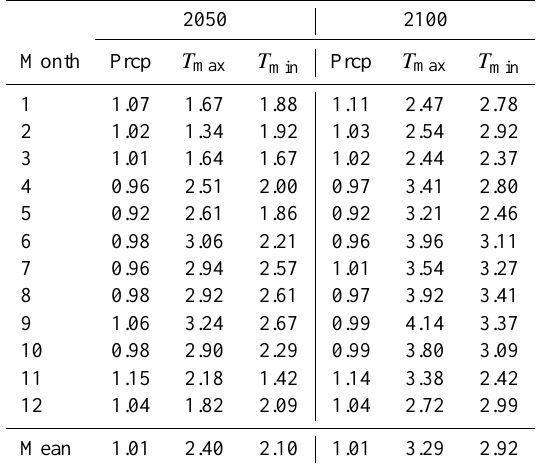
Fig. 5. Change in precipitation expressed as (a) mmday − 1 and (b) percentage for mid-century (green) and end of century (light blue). Table 2. Delta perturbations for SRES B1 emissions scenario, for decade centered on 2050 and decade ending in